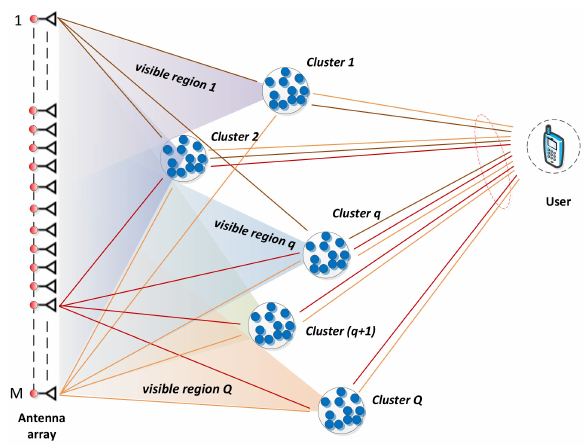
Figure 3. Nonstationary of Multipath over the Antenna